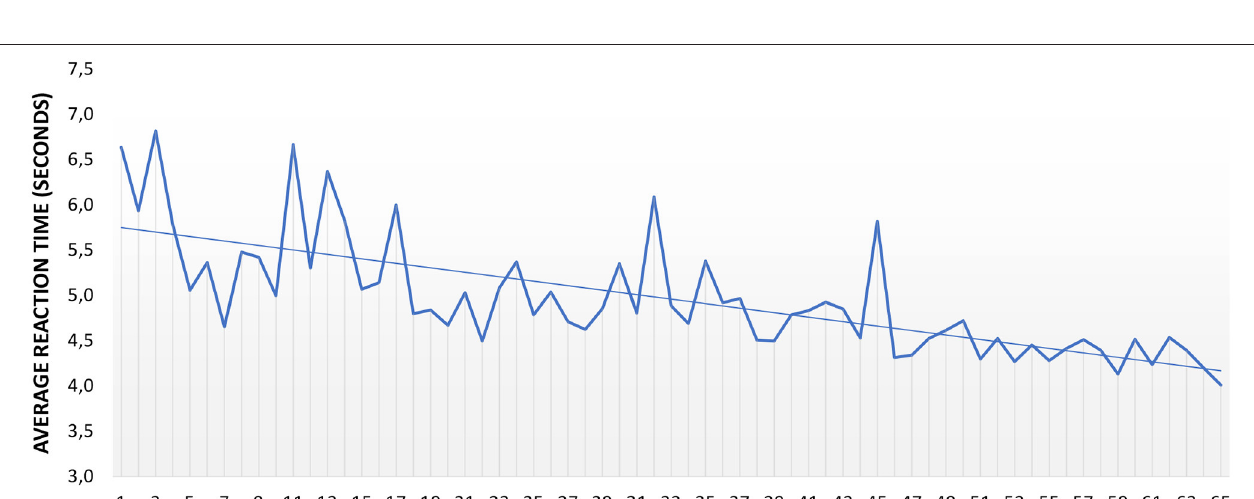
FIGURE 6 | Emotion identification errors. The trend line shows a negative slope of 1.7%.